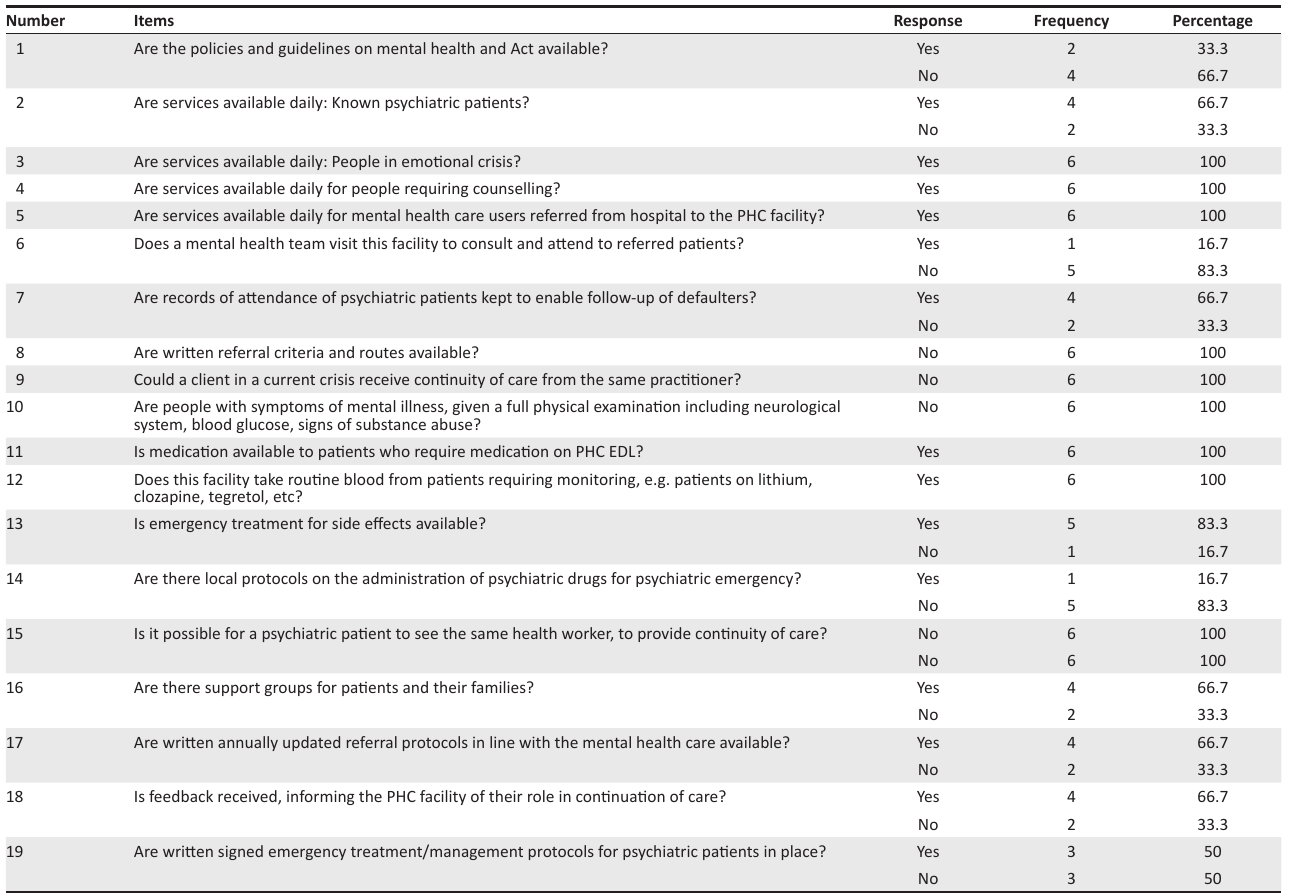
TABLE 4: Results from PHC nurses in-charge ( N =